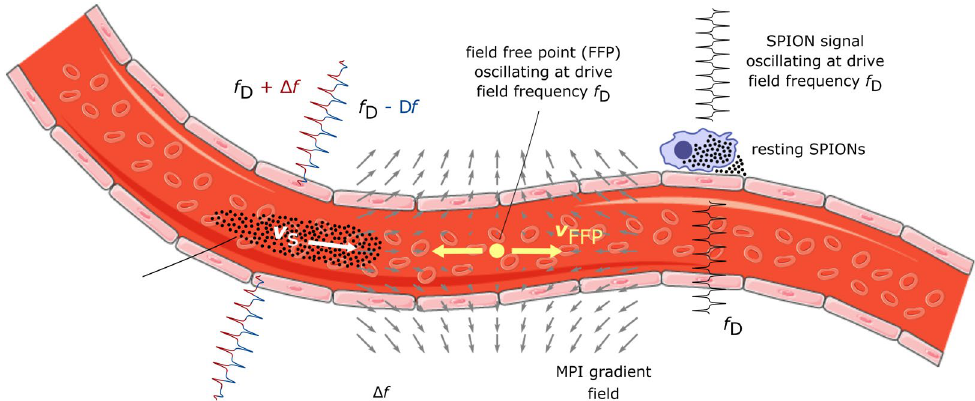
Figure 1. Illustration of the Doppler-MPS working principle. The moving SPIONs are exposed to the oscillating homogeneous drive field, superimposed by the selection field, which features a field free point (FFP) in the center. While the FFP is oscillating at the drive field frequency f D in one dimension, the signal emitted by the moving SPIONs exhibits a frequency shift f D ± (cid:31) f , which is a function of the SPION velocity v s and can therefore be exploited for velocity quantification. The signal emitted by resting particles is oscillating at the drive field frequency f D and thus can be distinguished from the signal emitted by moving particles. (The image was built upon material from Servier Medical Art (http:// smart. servi er. com), which is licensed under Creative Common Attribution 3.0 Unported License (CC BY 3.0), https:// creat iveco mmons. org/ licen ses/ by/3.